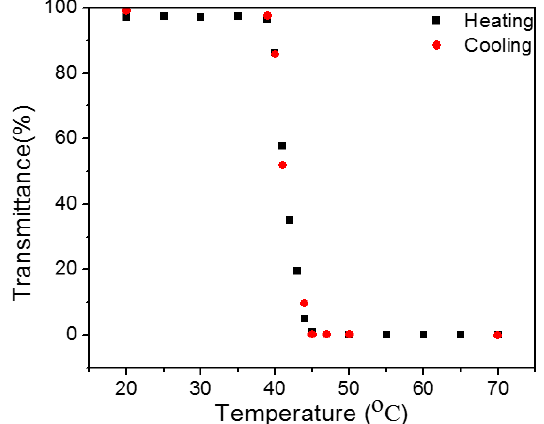
Figure 6. Thermal and optical behaviour of 2 wt. % HPC in aqueous solution at spectra of 600 nm under heating (transmittance change with increased temperature) and cooling (transmittance change with subsequent reduction in temperature) conditions.